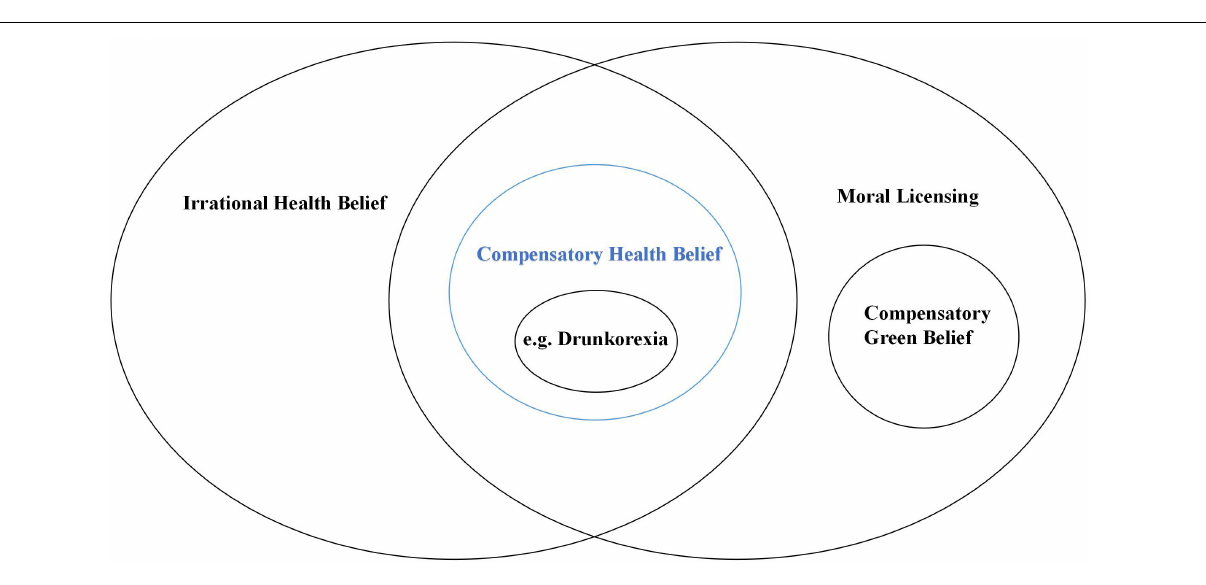
FIGURE 3 | Relationship between CB and the related